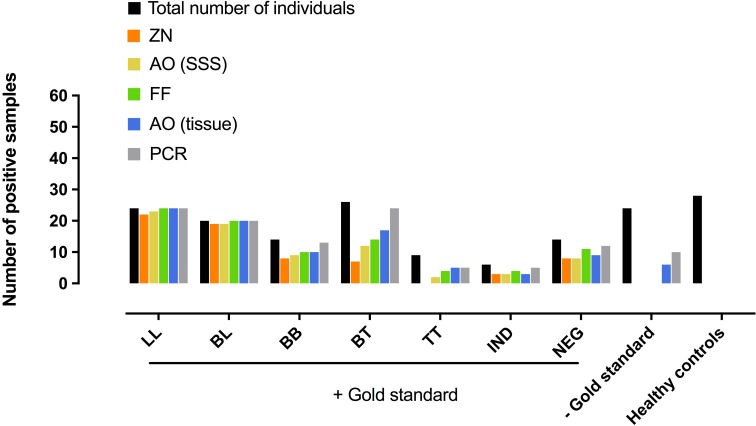
Histopathological repartition of the gold standard positive and negative samples with the number of positive sample and positivity rate (%) for each laboratory tests–HB: High bacillary load included samples from the LL, BL and BB groups; LB: Low bacillary load included samples from the BT, TT, INT and NEG groups–The graphic show the high positivity rate for AO-tissue and PCR in all groups compared to other methods.